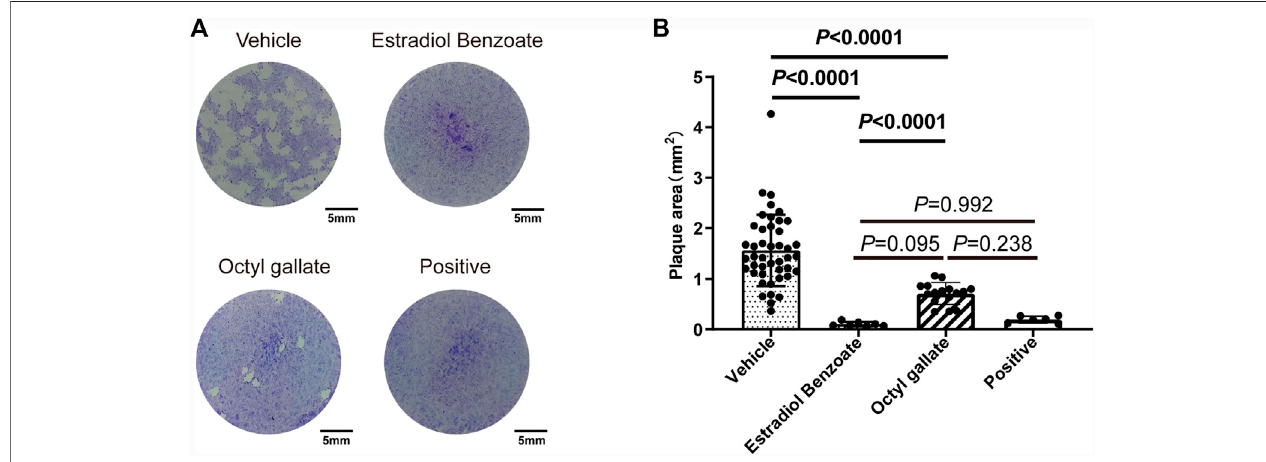
FIGURE3| Effectsofestradiolbenzoateandoctylgallateonthelyticcycleofparasites. (A) HFFmonolayersinfectedwith100tachyzoitesweretreatedwith5 μ Mof estradiol benzoate, octyl gallate, or pyrimethamine for 7 days. (B) Plaque areas were measured and shown as the mean ± SD from one experiment representative of three independent experiments.